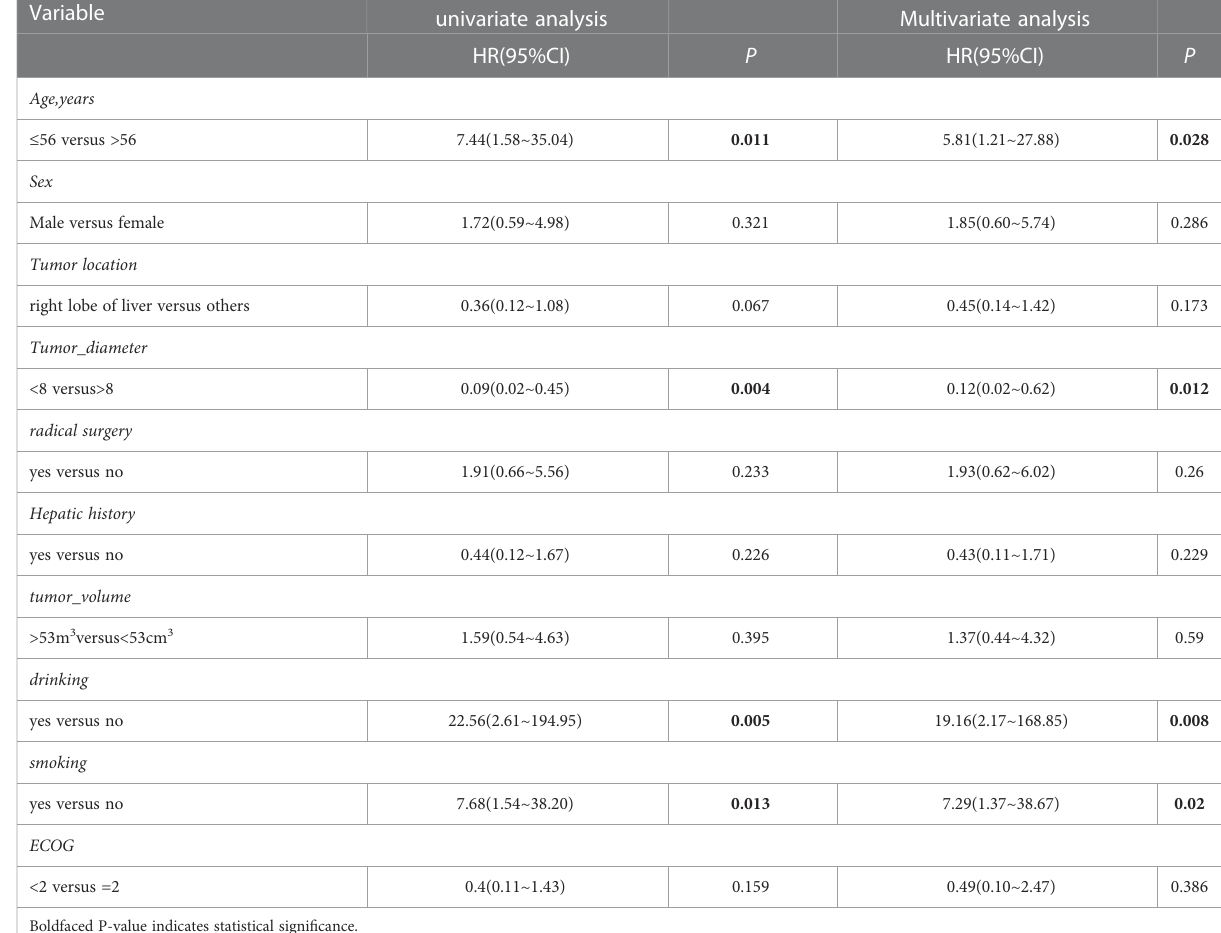
TABLE 2 Univariate and multivariate cox hazards analysis for OS in patients with